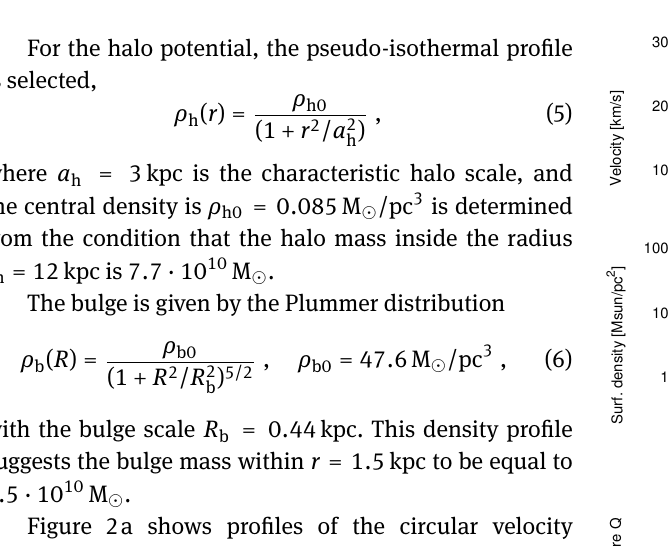
Figure 1. Examples of disc galaxies with three or more peripheral arms (from the left): M83 (RGB, Anglo-Australian Observatory), NGC 1187 (BV, VLT), NGC 5054 (JHK, 2MASS), ‘Milky Way’ (reconstruction).